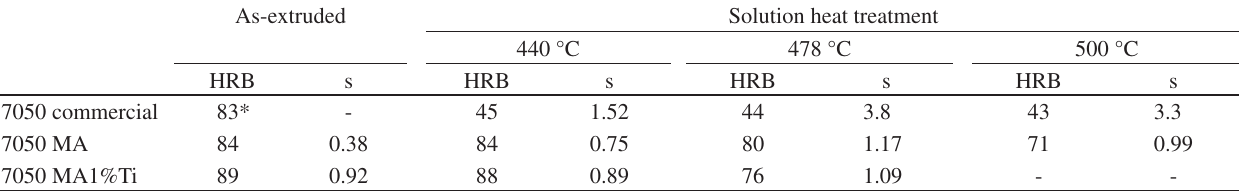
Table 1. Rockwell B Hardness testing results (HRB) and standard deviations (s), for samples in the as-extruded condition and after solution heat treatment at three temperatures.